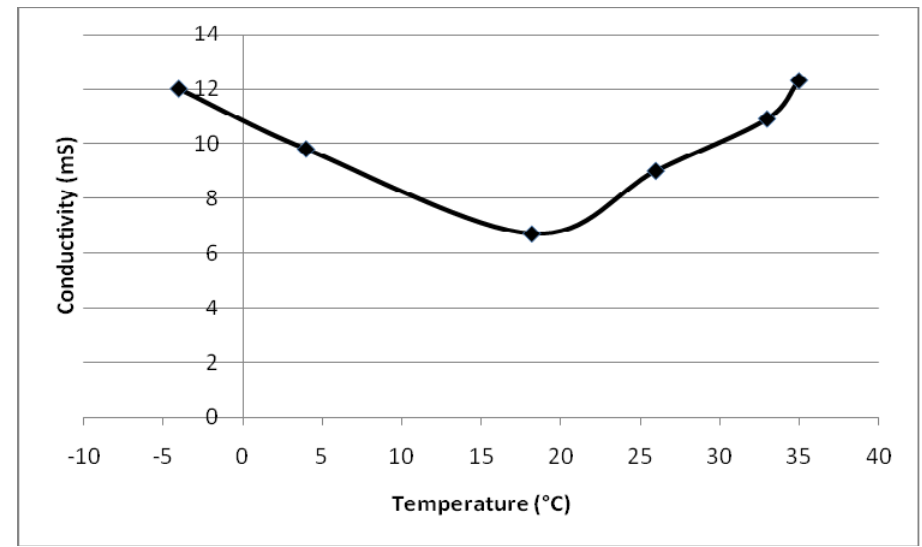
Figure 12. Conductivity vs. temperature change of PEGDMA with dopant LiClO (1 hr irradiation).